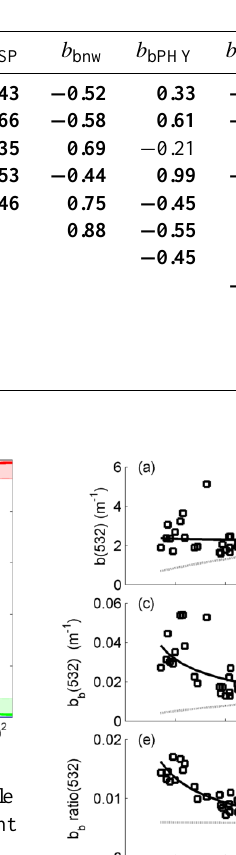
Table 1. Pearson correlation coefficient ( r) matrix for parameters that are either directly measured or derived from the inversion. S represents salinity. The values in bold face indicate that the correlations are statistically significant ( p < 0.05). The scattering variables ( b nw and b bnw , and their components of PHY, NAP and VSP) are measured and estimated at 532nm. The absorption coefficients for CDOM and NAP are estimated at 412nm. The [Chl] is measured using HPLC.